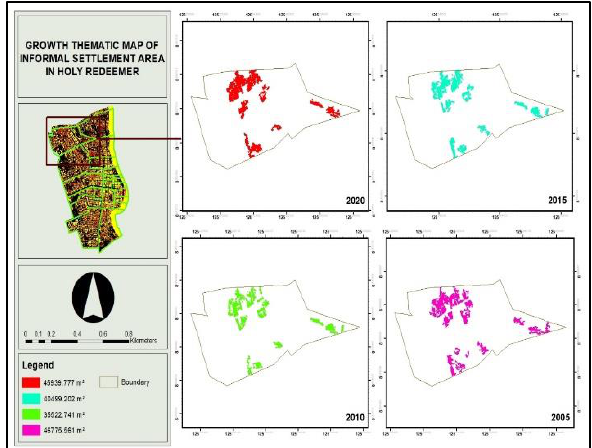
Figure 10. Thematic Map of Brgy. Holy Redeemer from